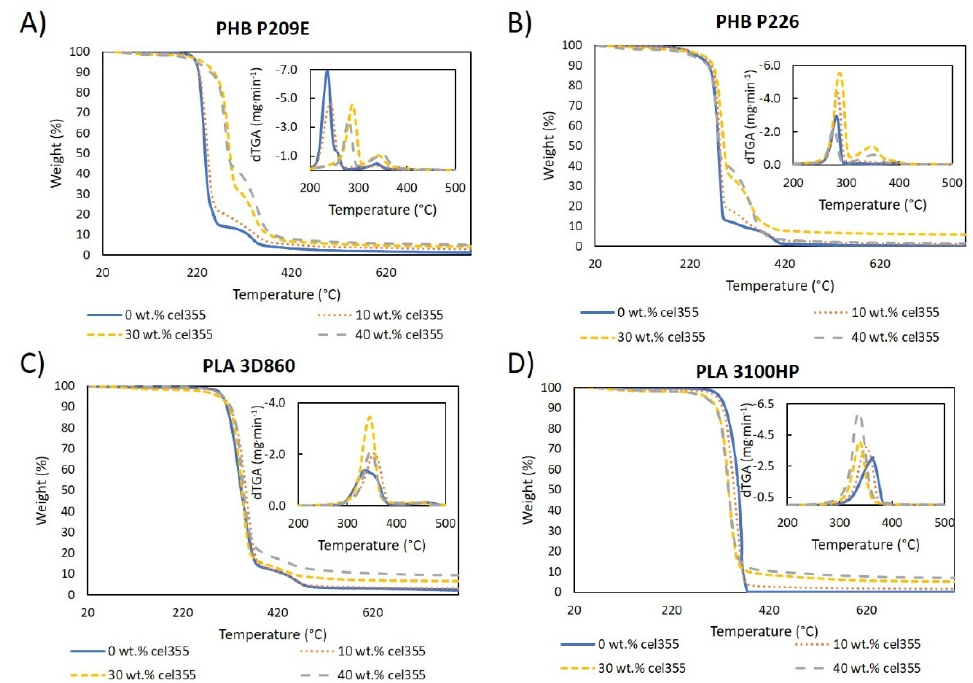
Figure 11. Thermogravimetric and derivative (dTGA) curves of the pure polymeric matrices and composites with different loads of Cel355 (10, 30, and 40 wt.%) in matrices of: ( A ) PHB P209E; ( B ) PHB P226; ( C ) PLA 3D860 and ( D ) PLA 3100HP.